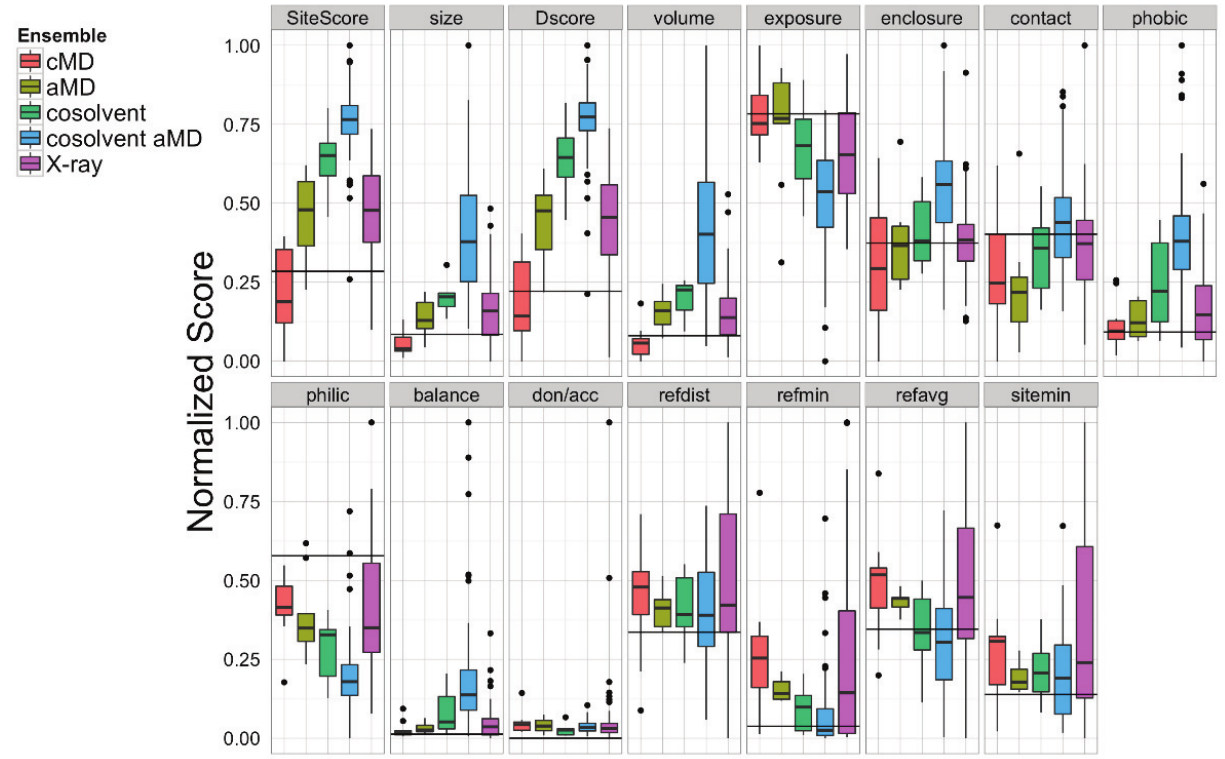
Figure 7. Sitemap analysis of the BH3-domain binding site in the ensemble of Bcl-xL conformations obtained from cMD, aMD low boost (aMD), cosolvent, cosolvent low boost aMD, and the experimental structures. The horizontal black line in each panel denotes the values calculated from the single X-ray apo Bcl-xL